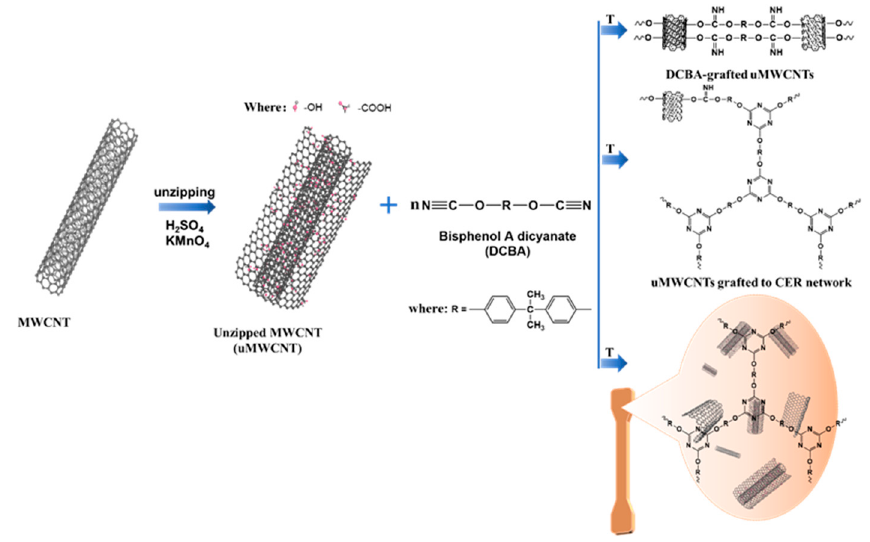
Figure 1. Schematic illustration of the preparation process used for CER/uMWCNTs nanocompo- sites.